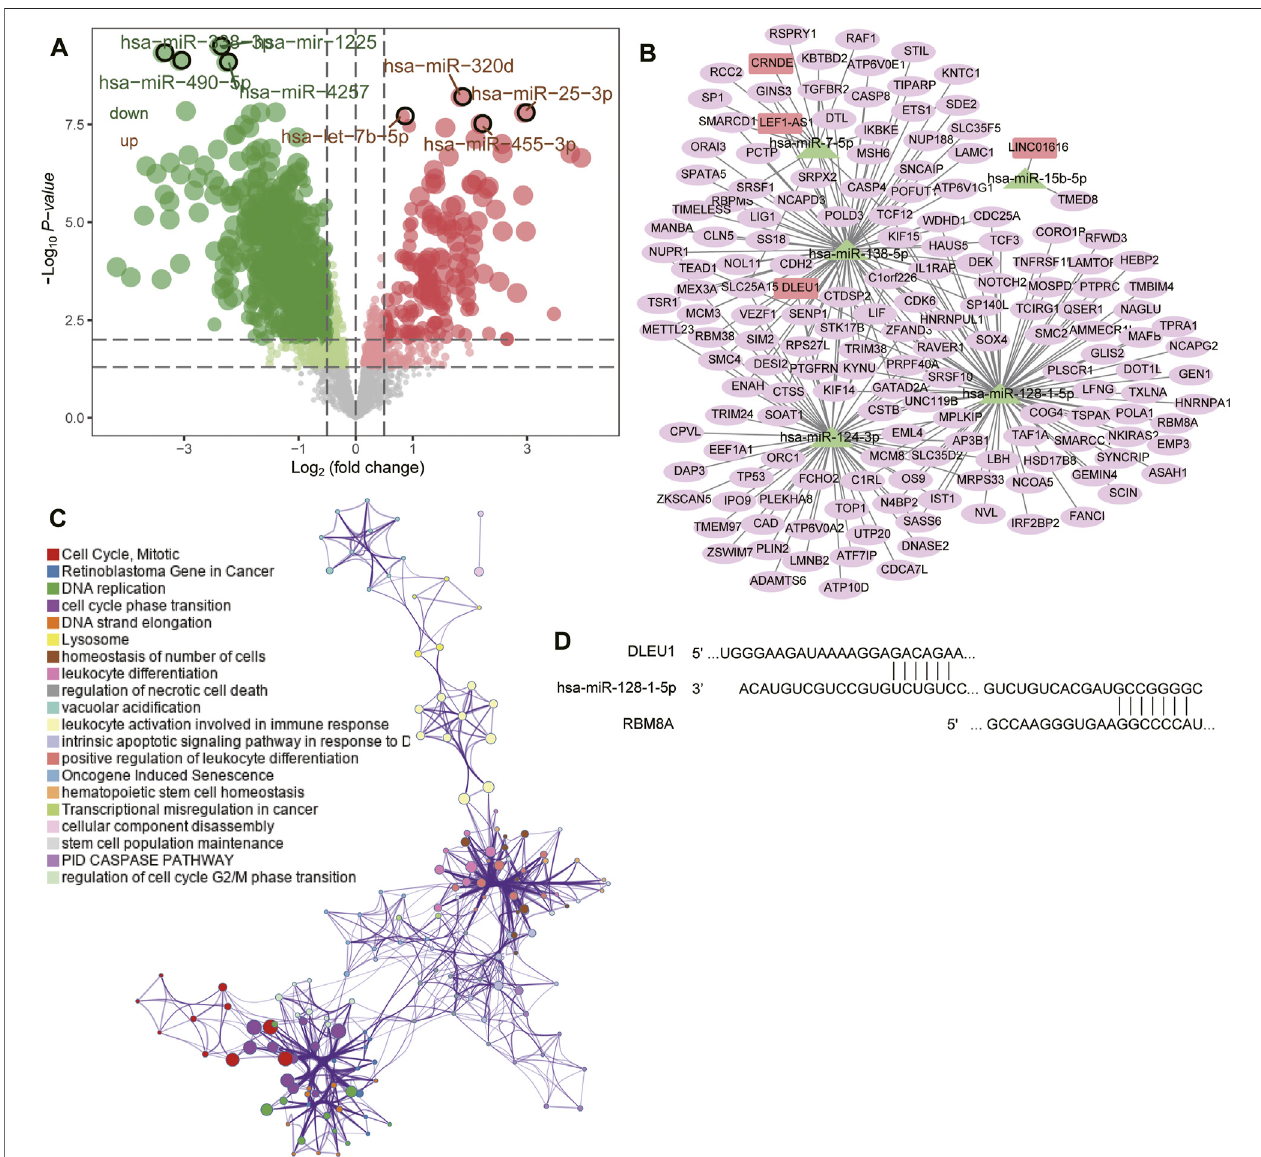
FIGURE 5 | Prediction of target genes and construction of a competing endogenous RNA (ceRNA) network. (A) Volcano plot of differentially expressed miRNAs between GBM and controls in GSE90603. Red means upregulated; green, downregulated. (B) The ceRNA network in GBM. Rectangles indicate lncRNAs; triangles, miRNAs; and ellipses, mRNAs. (C) Functional enrichment analysis of differentially expressed mRNAs in the ceRNA network. (D) Base pairing of the 3 ′ -untranslated regions in the DLEU1 and RBM8A mRNAs with has-miR-128-1-5p, as predicted by lncBase 3 and TargetScan, respectively.